Question: Write a single sentence explaining what this figure depicts.
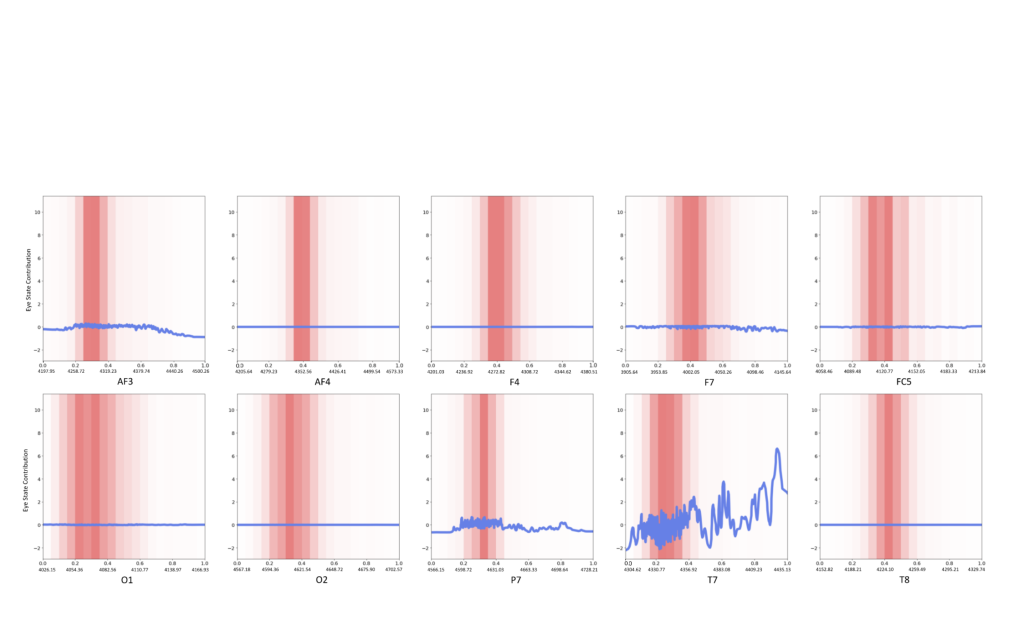
Answer: shows that AF4, F4, F7, FC5, O1, O2, and T8 have almost no contribution towards FocusLearn in predicting eye state from the EEG, and AF3 and P7 have minimal contribution towards the model prediction. This means that electrodes placed at these regions do not contribute much to FocusLearn in predicting the eye state. On the other hand, the electrode placed on the T7 region is the most important one in predicting the eye state. Its plot shows that higher T7 values means it is more likely